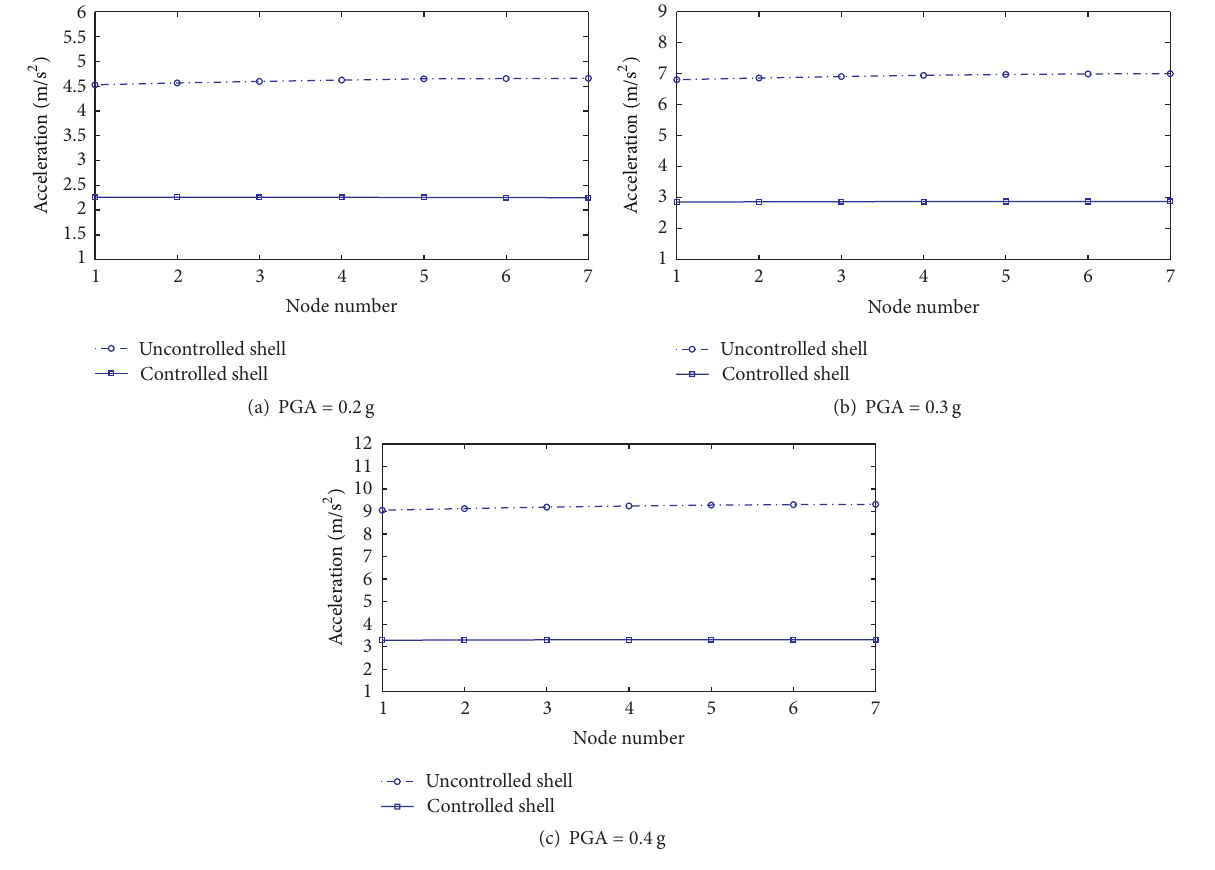
Figure 10: Peak value of acceleration in 𝑋 direction for selected nodes under Sylmar wave. Table 2: Control effect of peak base shear in 𝑋 direction (Units in